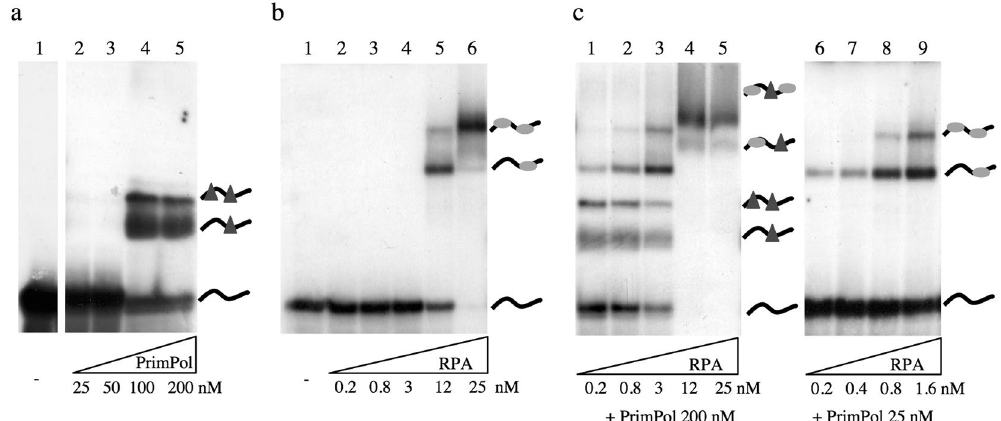
Figure 3. Mutual interaction of PrimPol and RPA with ssDNA. EMSA carried out as described in Materials and Methods, in the presence of a 65-mer ssDNA (2 nM) and the indicated concentration of PrimPol ( a ), RPA ( b ), or a combination of both proteins ( c ). The different retarded bands, representing individual protein:ssDNA complexes, were resolved by electrophoresis and autoradiography.